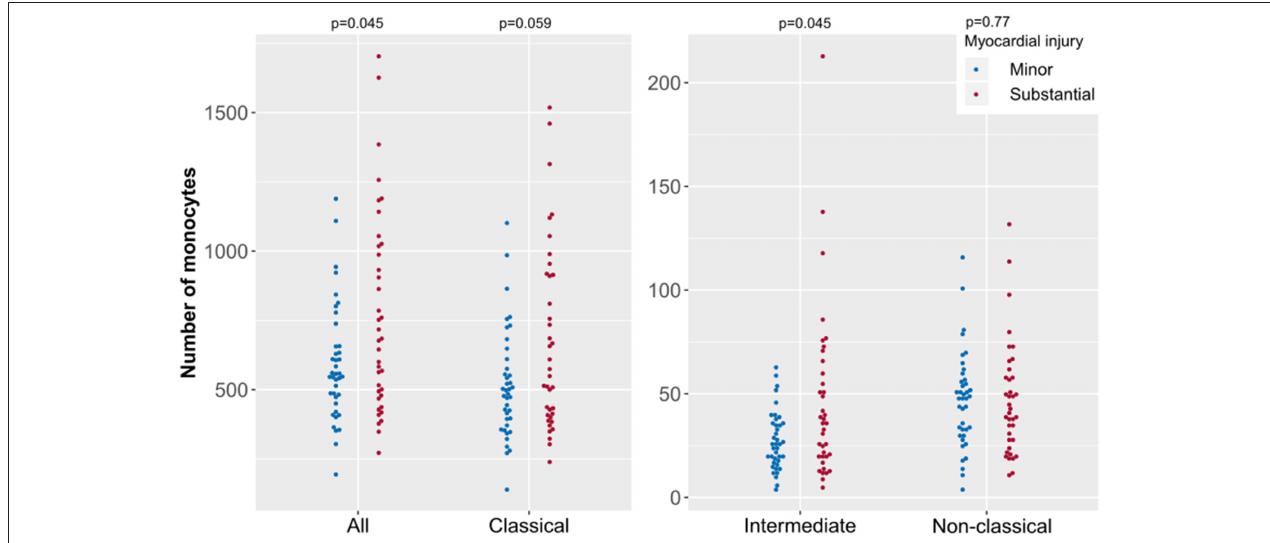
FIGURE 3 | Absolute monocyte counts of specific subsets according to extent of myocardial injury in acute coronary syndrome (ACS). Presented are data from the ACS cohort ( n = 82) including patients with substantial ( n = 42) and with minor myocardial injury ( n = 40). ACS patients were stratified as having minor or substantial